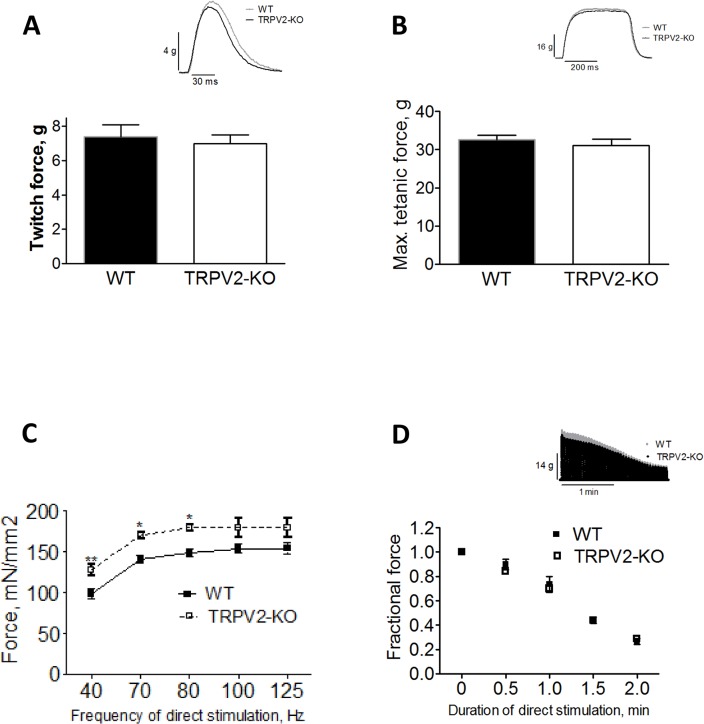
Contractility and fatigability of isolated skeletal muscles from TRPV2-KO and WT mice.(A) Mean twitch force produced by the EDL muscle of WT and TRPV2-KO mice. Inset: representative recording of twitch force. (B) Maximum tetanic force produced by the same muscles in response to a single tetanus of 80 Hz, 400 ms duration. Inset: representative recording of maximum tetanic force. (C) Specific Force vs. stimulation frequency of WT (ο) and TRPV2-KO (•) EDL (**P<0.01, *P<0.05). (D) Force vs. duration of stimulation for WT (ο) and TRPV2-KO (•) EDL muscles subject to fatiguing stimulation (40 Hz/750 ms tetani repeated every 3 sec for 2 min). Inset: representative force recordings. (n = 5–6 muscles from 4 mice of each genotype.) TRPV2-KO skeletal muscles are not significantly different from WT.